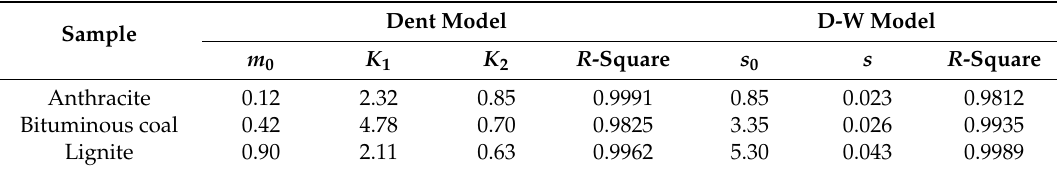
Table 3. Fitting parameters by the models.